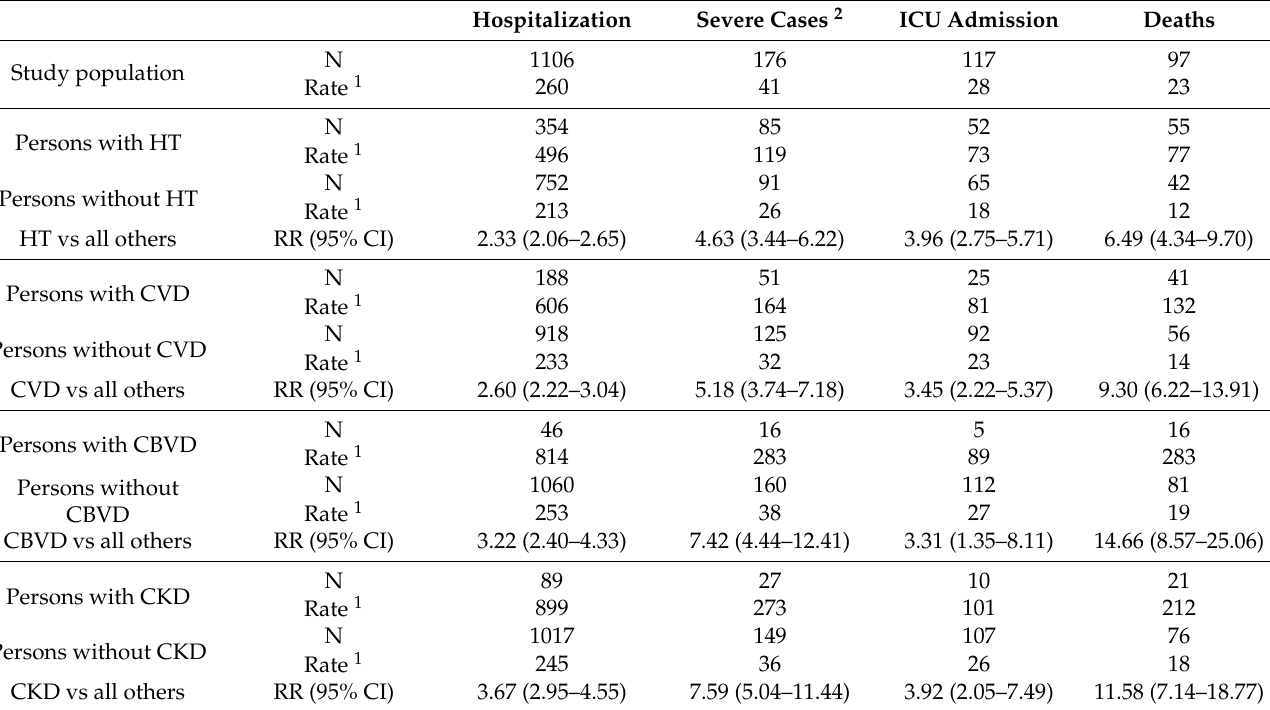
Table 2. Cases and incidence rates 1 of confirmed COVID-19 that were admitted to the hospital, to intensive care unit or who died, according to the prior diagnosis of hypertension, cardiovascular disease, cerebrovascular disease or chronic kidney